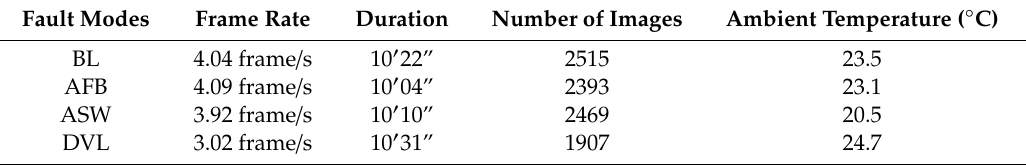
Figure 2. Fault simulation: ( a ) air filter blockage (AFB), ( b ) asymmetrical stator winding (ASW), ( c ) discharge valve leakage (DVL). Table 1. The number of images recorded in various failure modes and the ambient temperature.